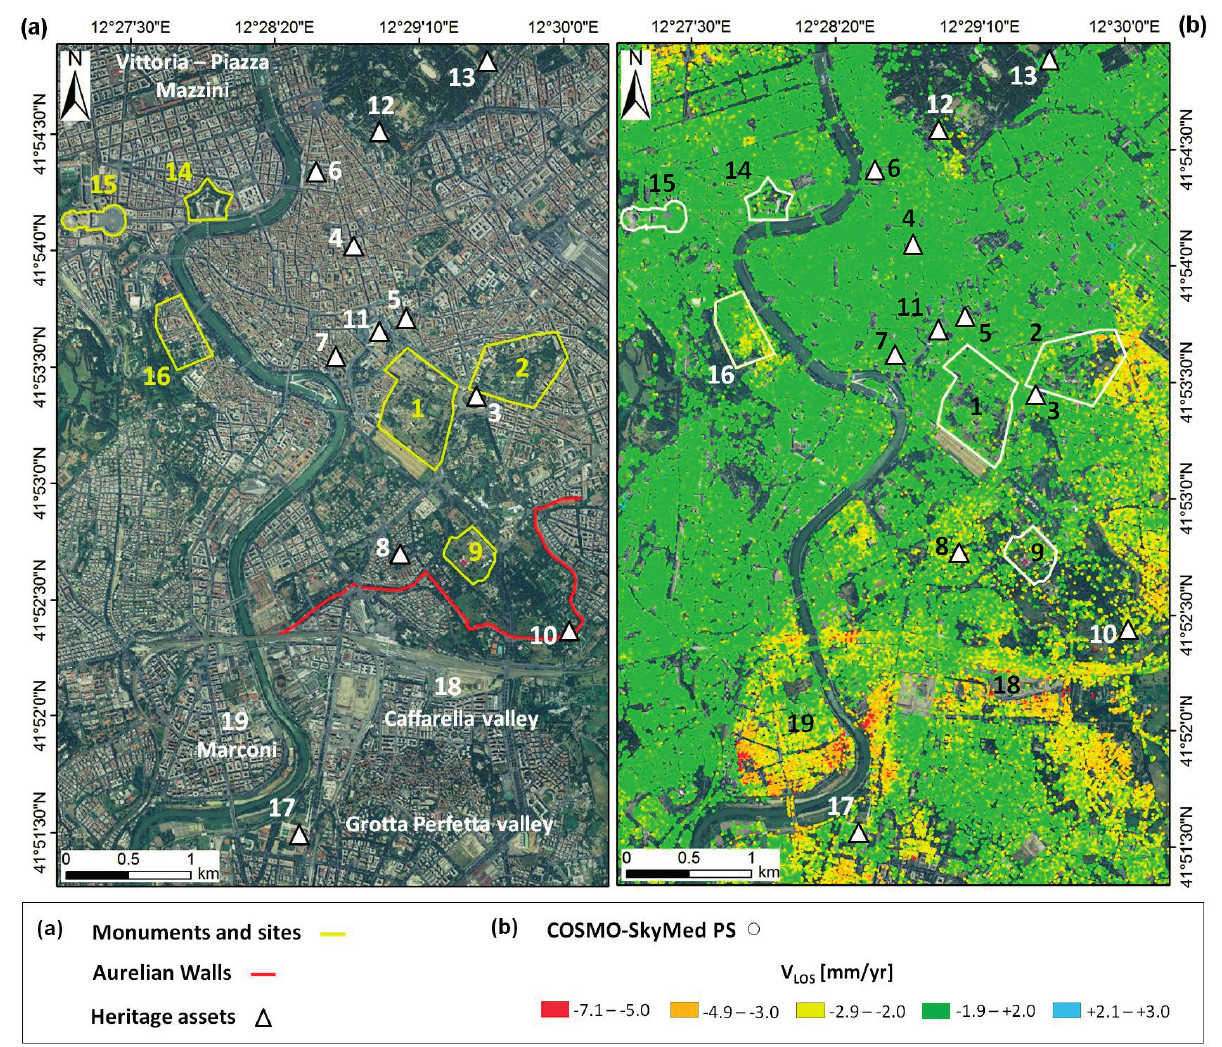
discussion in Section 3.2. ( b ) Spatial distribution and associated V LOS estimates of the COSMO-SkyMed StripMap HIMAGE PS (March 2011–June 2013) obtained from the StaMPS processing ( cf . also Figure